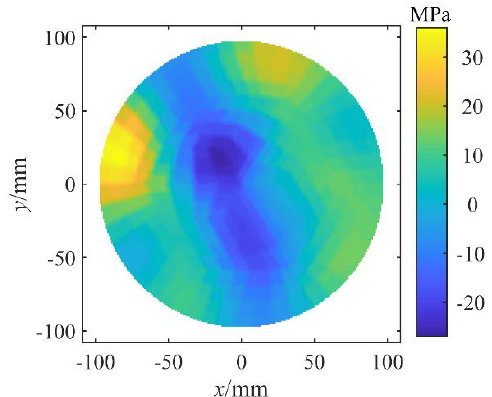
Figure 15. Calculated residual stress using Tikhonov regularization method under continuity con- straints. The calculated residual stress distribution presented the feature of being continuous between adjacent subareas.